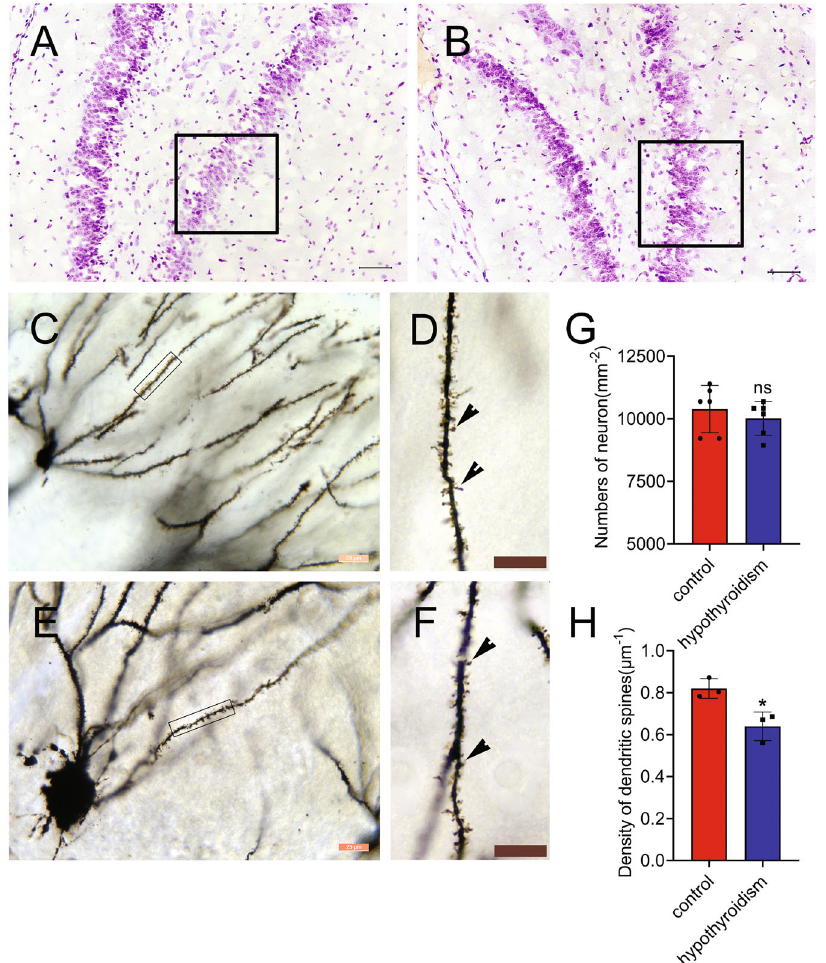
Fig. 2 Effects of CH on the spine density of DGCs in the DG subregion of rat pups. A , B Nissl ’ s staining of P21 pup hippocampus with or without CH. C – H Comparison of dendritic spine density of DGCs by Golgi staining between P21 pups with or without CH. The rectangles in A and B indicate detection sites of dendritic spines in DG subregion. The rectangles in C and E indicate region magni fi ed in D and F . H , G Statistical analysis of C , E and A , B , respectively. Arrowheads indicate spines. Statistic analysis of spine density in triplicates each 15 fi elds. Scale bars, 50 μ m in A , B ; 25 μ m in C , E ; 10 μ m in D , F . Error bars represent the standard deviation (* P <